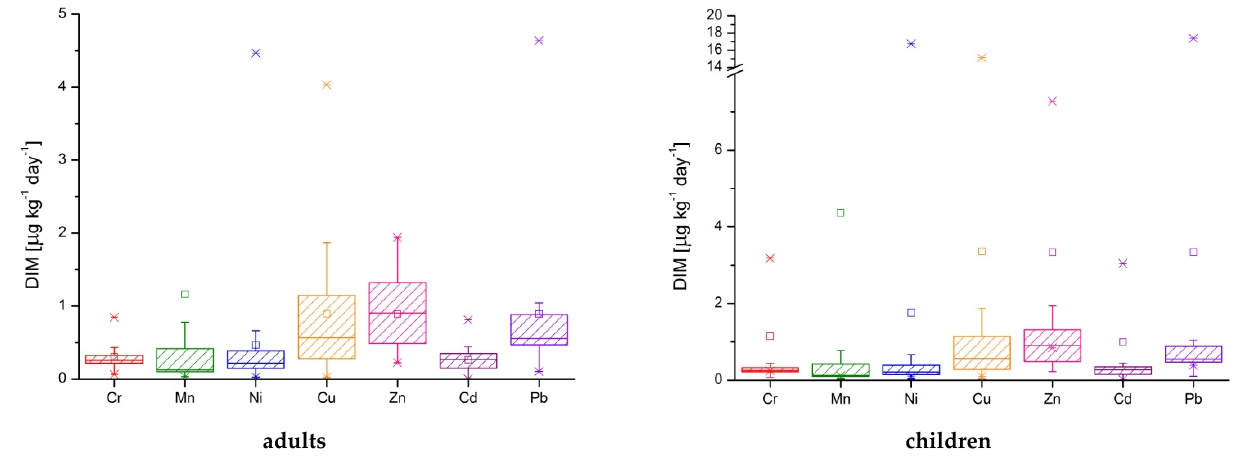
Figure 4. The daily intake metals represented as box-plots for seven toxic metals in well water. Table 9. Health risk index (HRI) values of seven metals in well water samples, as well as the cumulative health risk (T THQ ).